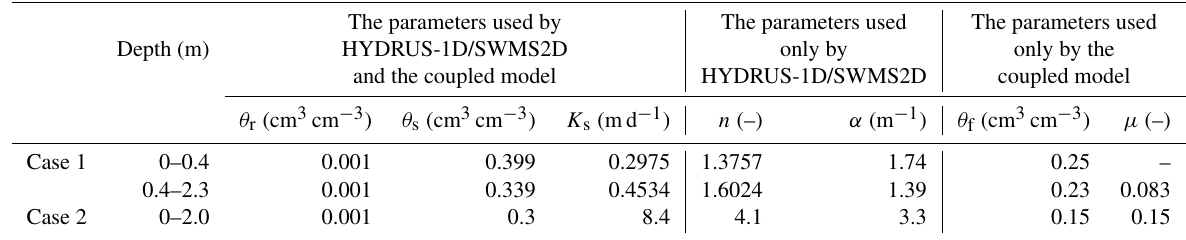
Table 1. The hydraulic parameters of case 1 and case 2.